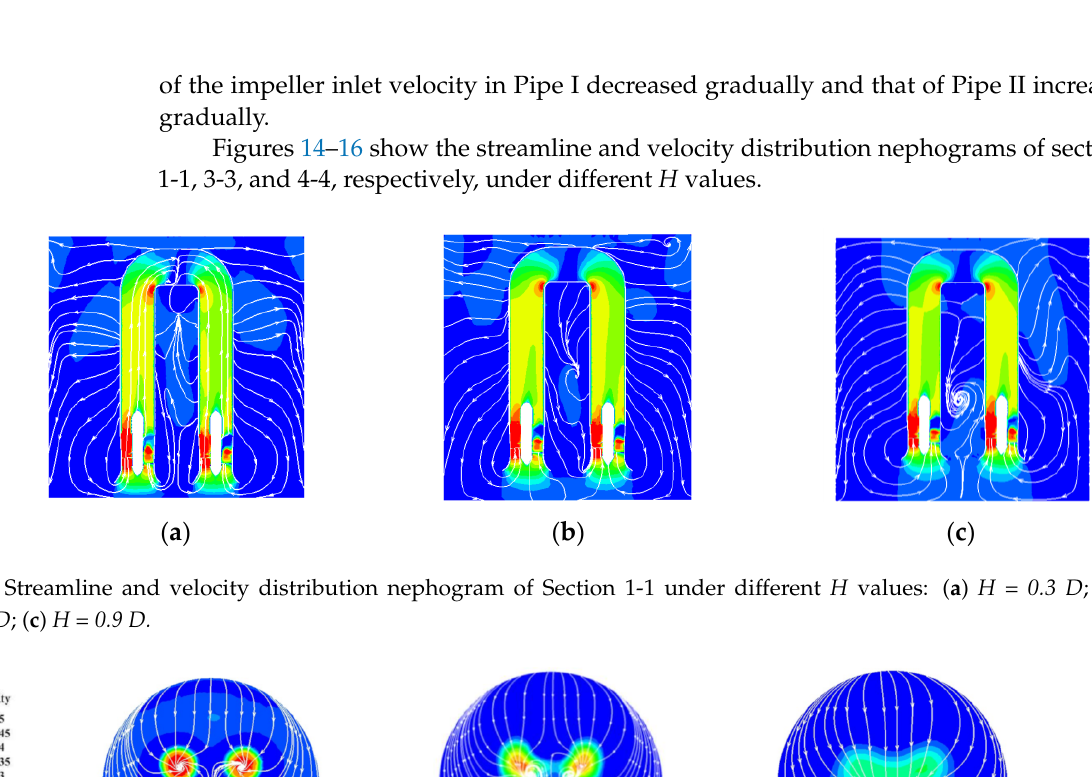
Figure 15. Streamline and velocity nephogram of Section 3-3 of the sump under different H values: ( a ) H = 0.3 D ; ( b ) H = 0.6 D ; ( c ) H = 0.9 D.